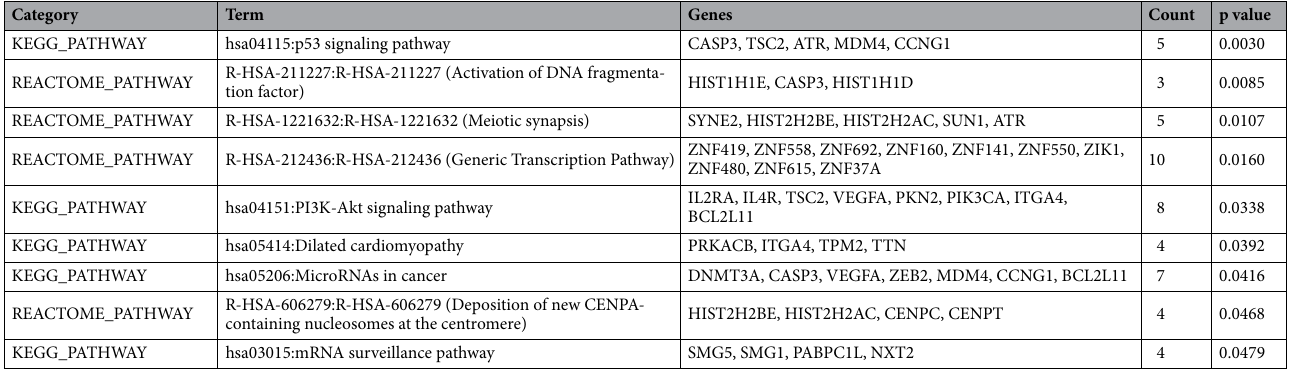
Table 4. Pathway analysis of upregulated genes in PD.